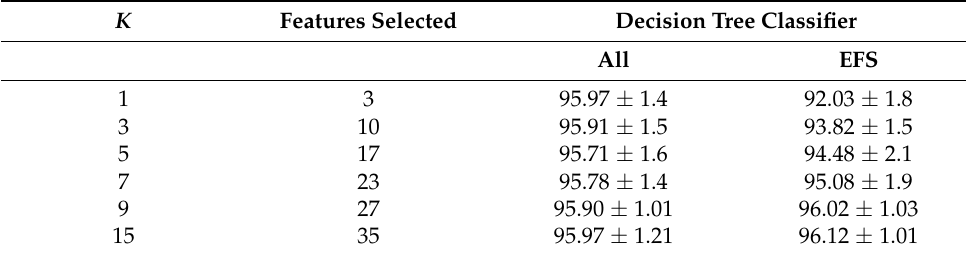
Table 1. Accuracy results—decision tree classifier. K